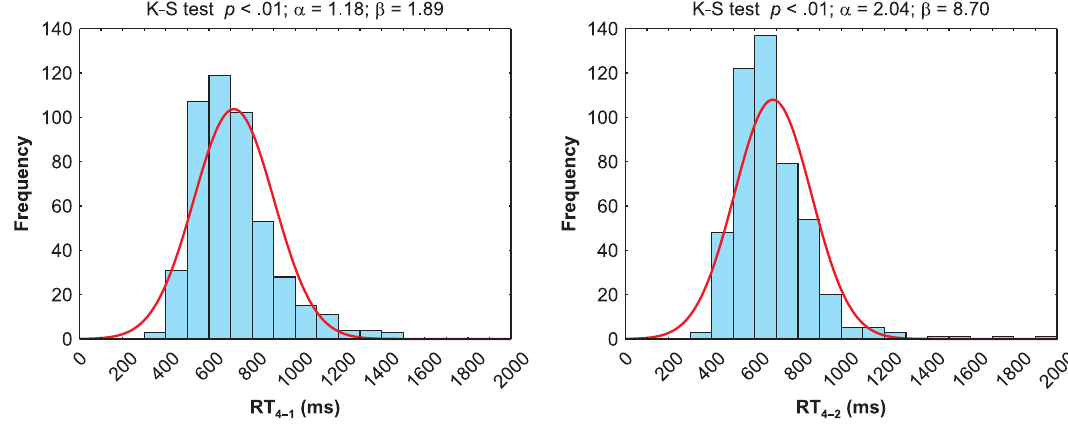
, RT = reaction 1–1 1–2